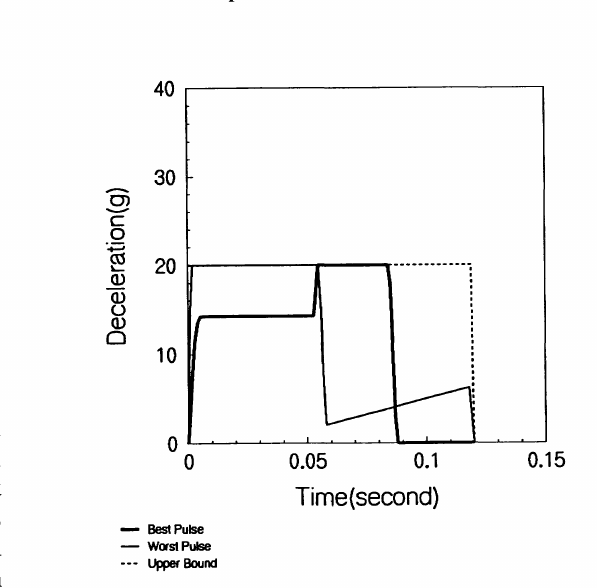
FIGURE 20 Best and worst pulses via proposed cor